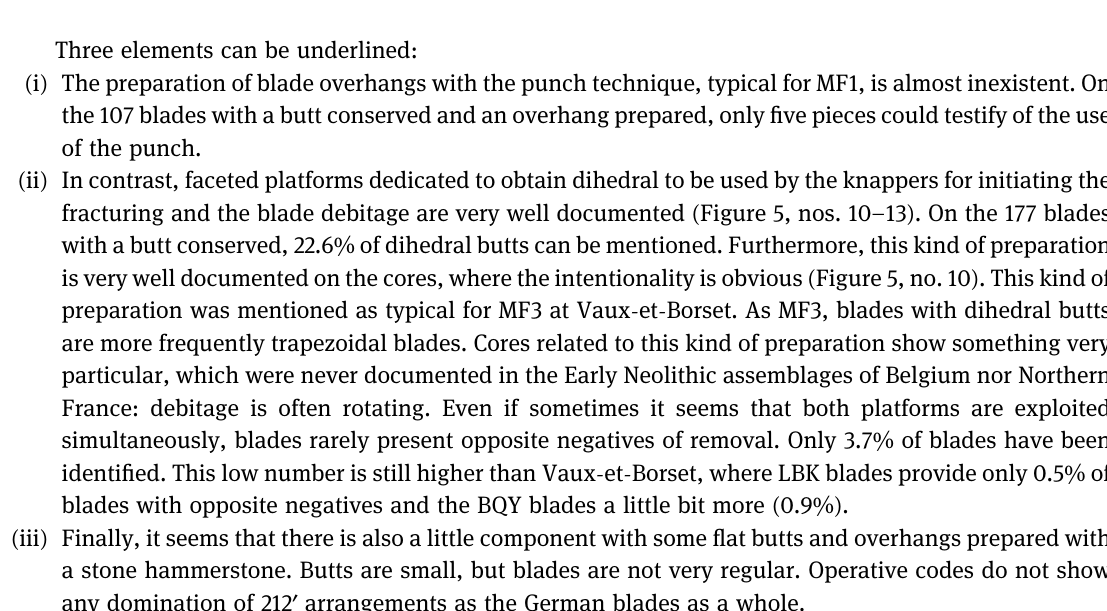
The percentage is indicated in